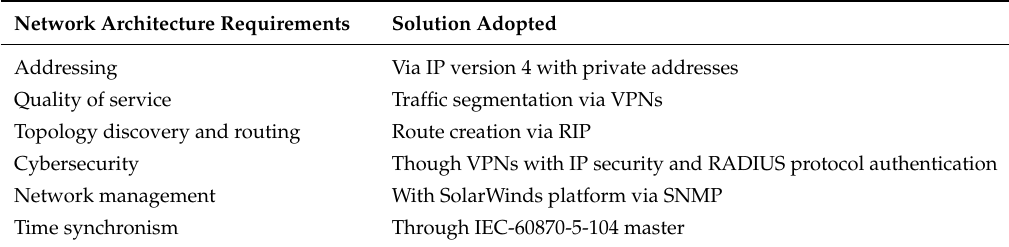
Table 1. Summary of solutions for the logical transmission